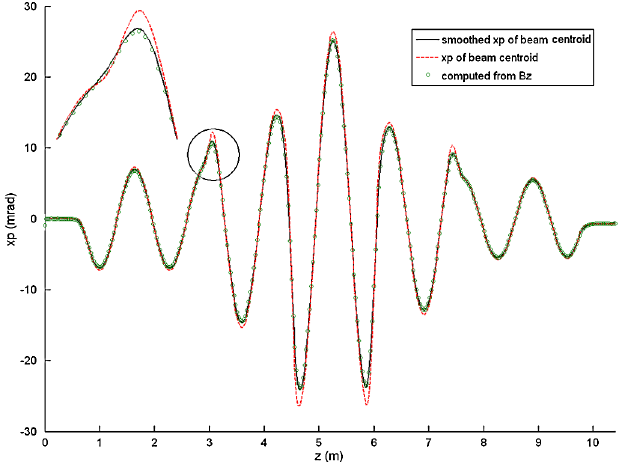
9. Comparison between the computed beam deflection angle vs z and real beam deflection angle. The extra curves on the top left are the zoom of the curves in the